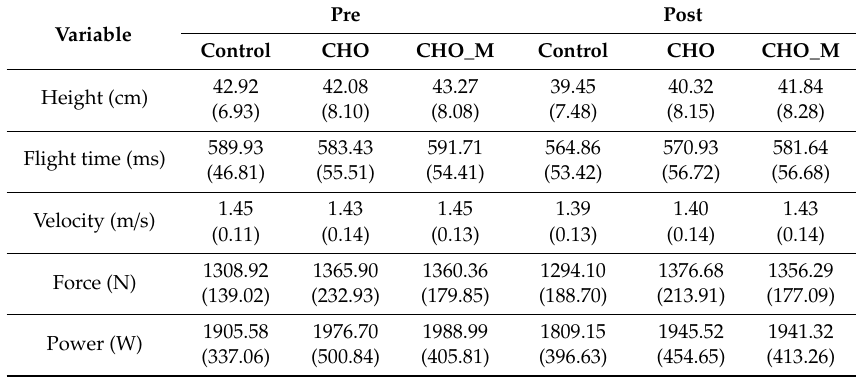
Table 1. The performance of five dimensions for vertical jump between pre and post-test (M ±